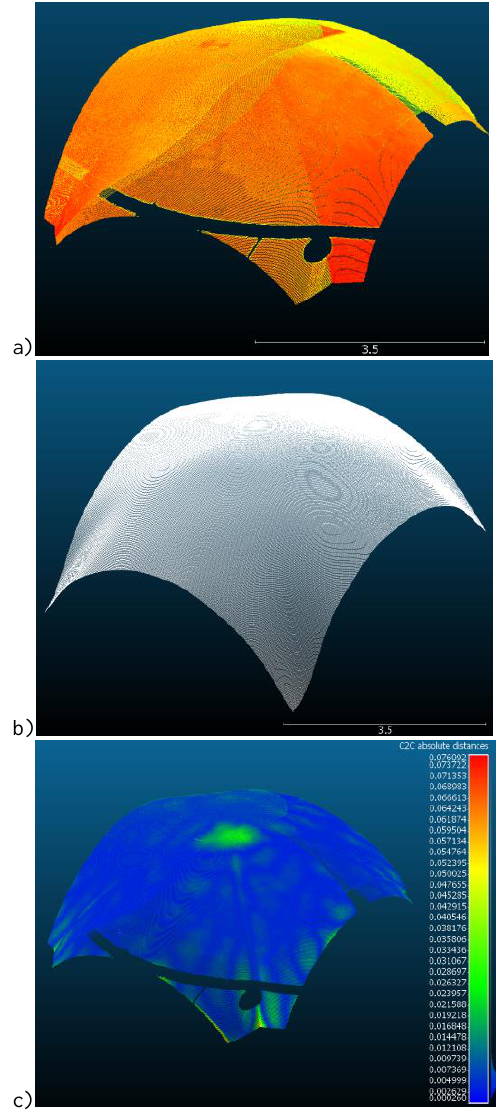
using 4,561 points and a variable number of neurons (from 65 to 69). Data processing took less than 3 minutes and the results of the best 5 neural networks (average value) were used to create a new point cloud on a regular grid of 0.01 m x 0.01 m (Figure 12b). The final discrepancy estimated with CloudCompare between the averaged results and the original point cloud is 0.006±0.003 m.